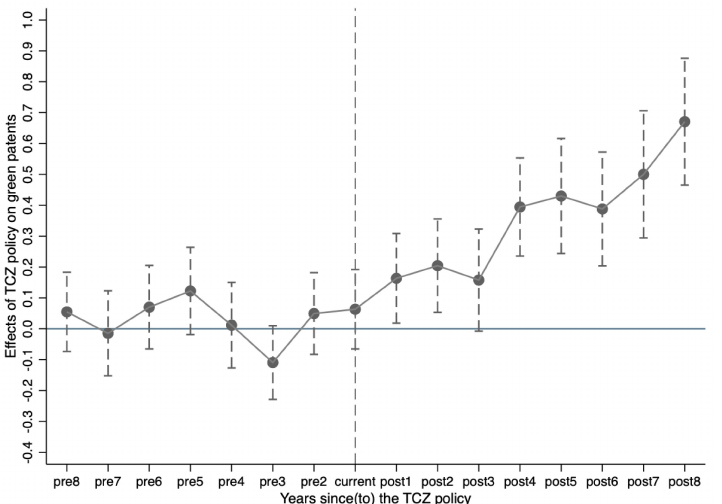
Figure 1. Treatment–year interaction coefficient for city–level green patent applications. Notes: Figure presents coefficient and 95% confidence intervals on Tcz × year interactions from the regression of Tcz × year interaction terms, including city–fixed effects and year–fixed effects. TCZ policy was implemented in 1998 (current), the year before TCZ policy was excluded (pre1). Standard errors in parentheses are clustered at the city–year